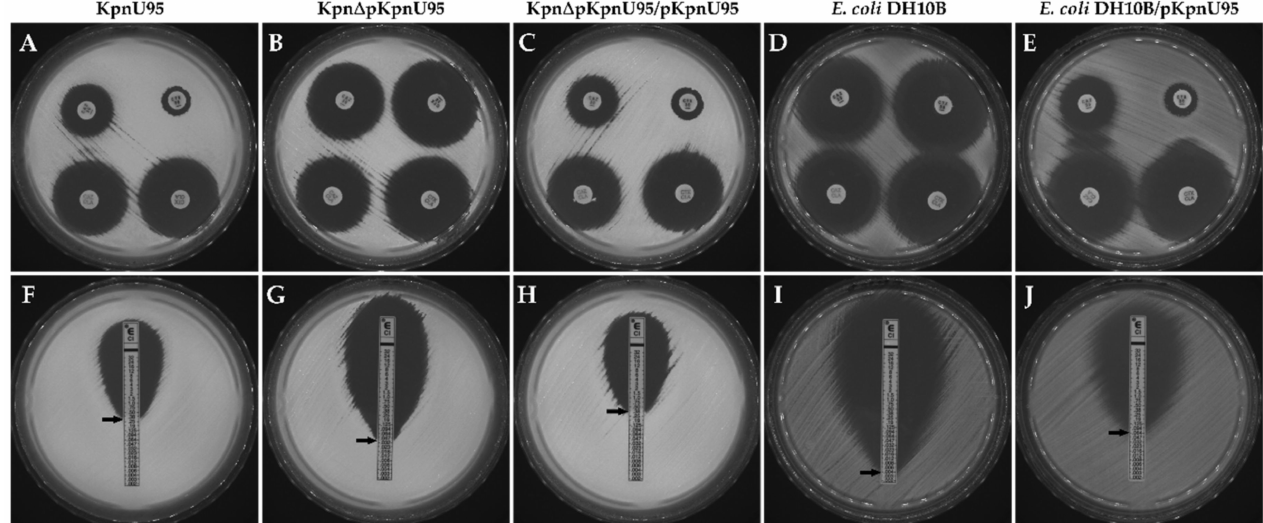
Figure 1. The effect of pKpnU95 on the ESBL phenotype and ciprofloxacin (CIP) MIC testing. ESBL confirmation as- say using ceftazidime (CAZ); upper-left disc, ceftazidime (CAZ); lower-left CAZ + clavulanic acid (CLA); upper-right, cefotaxime (CTX); and lower-right CTX + CLA ( A – E ); and Etest MIC testing of ciprofloxacin (CIP) ( F – J ). The clinical KpnU95 ( A , F ), the cured strain lacking the plasmid, Kpn ∆ pKpnU95 ( B , G ), the cured strain transformed with the plasmid, Kpn ∆ pKpnU95/pKpnU95 ( C , H ), E. coli DH10B ( D , I ) and E. coli DH10B/pKpnU95 ( E , J ). Images are representative of three biological